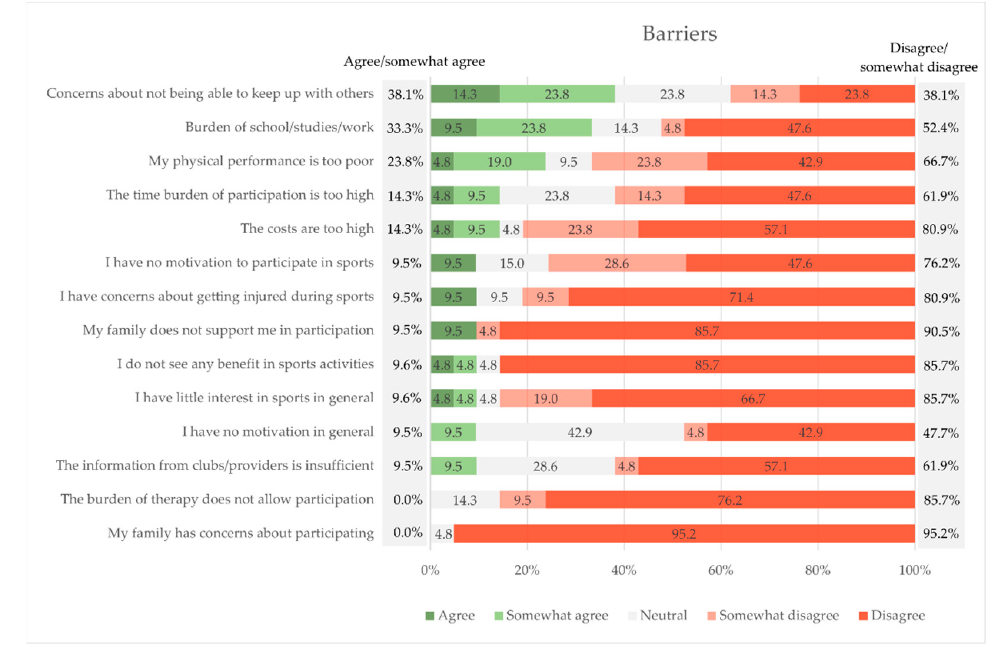
Figure 6. Barriers to general exercise participation.